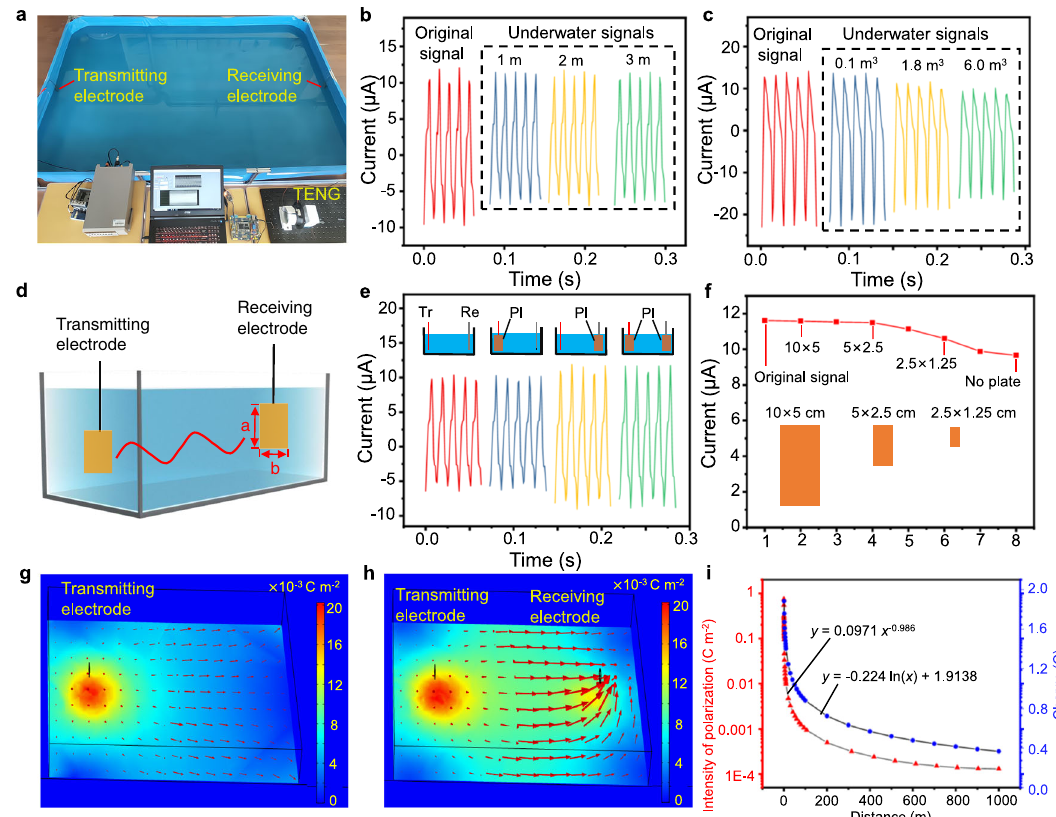
Fig. 3 The transmission performance of the underwater electric fi eld. a A photo of the experiment. b Comparison between the original TENG short-circuit current and received current signals in water. c Comparison between the original short-circuit current of the TENG and received signals under different water volume. d Schematic diagram of the electrode. e Comparison of the current signals received in water with different transmitting and receiving electrodes. Tr, Re, and Pl represents transmitting electrode, receiving electrode, and electrode plate respectively. f Comparison of the peak values of the received current signals with different receiving electrodes. Simulation diagram of the distribution of polarization electric fi eld ( g ) without and ( h ) with the receiving electrode. Color represents polarization intensity. i Variation of polarization electric fi eld and charges on the receiving electrode with the distance between the two